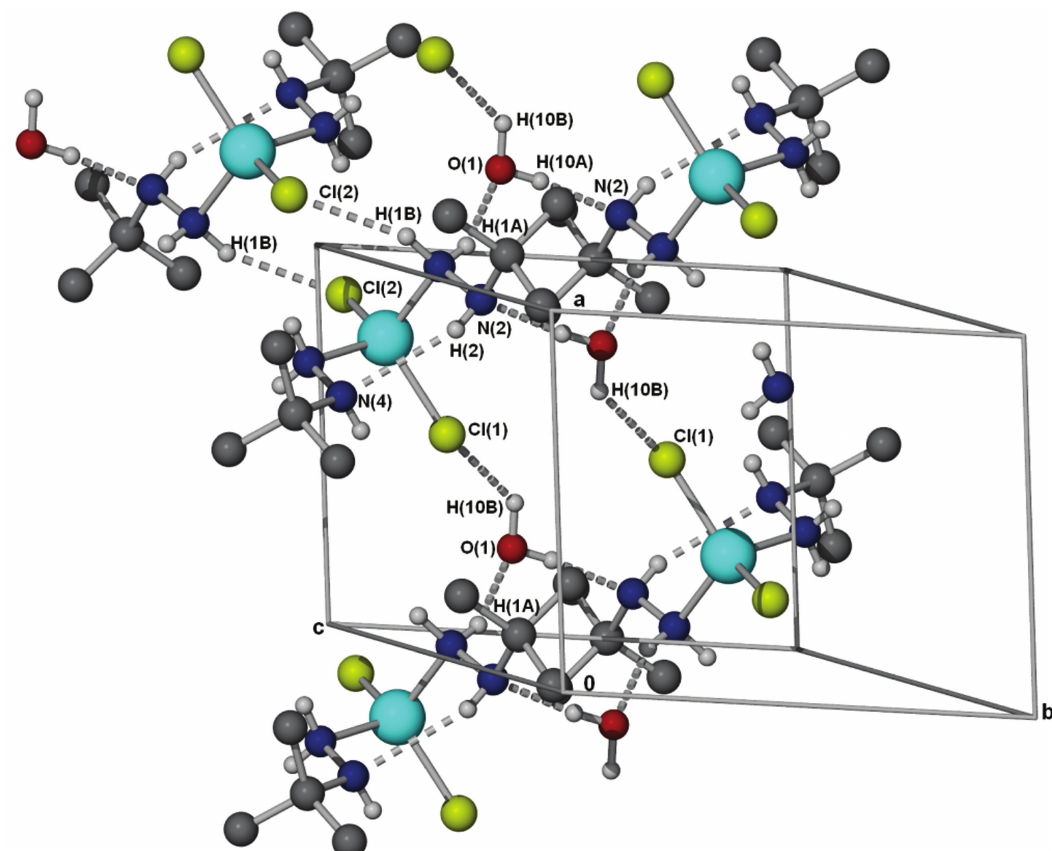
Figure 2: A section of the unit cell of 1 , showing the hydrogen bonds.